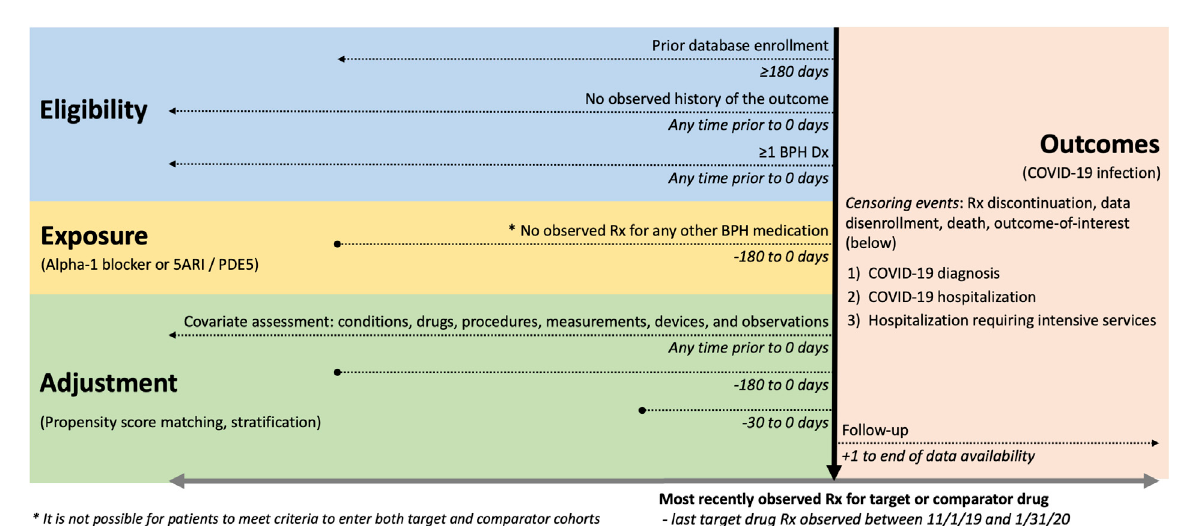
FIGURE 1 Alpha-1 blockers and susceptibility to COVID-19 study design schematic. We highlight eligibility criteria, exposure de fi nitions, adjustment strategies, index date speci fi cation (horizontal black arrow) and outcome de fi nitions and time-at-risk. Exposure involves prescriptions to drugs with RxNorm ingredients that map to medications indicated for treatment of